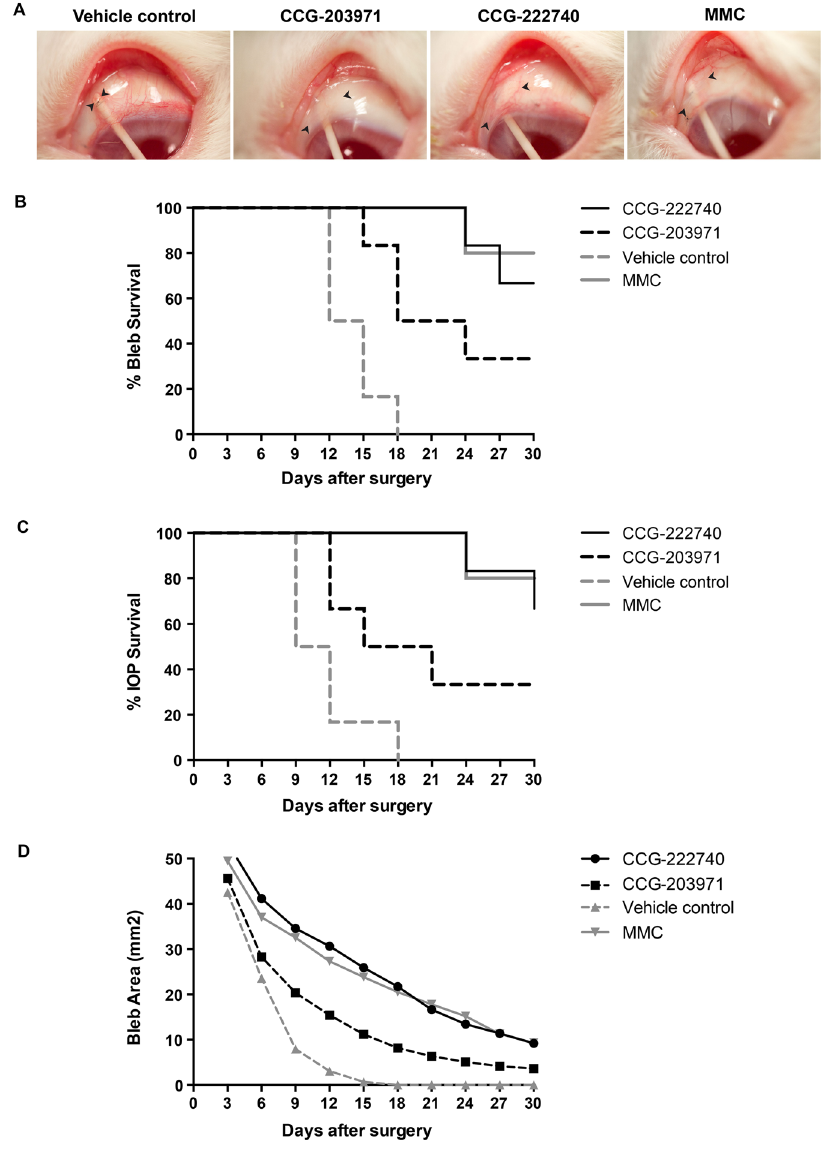
Figure 4. CCG-222740 and CCG-203971 increase the long-term success of surgery in a preclinical model of fibrosis. ( A ) Morphology of blebs after surgery and treatment with CCG-222740, CCG-203071, MMC or vehicle. Arrows indicate bleb edges. ( B ) Kaplan-Meier graph comparing the bleb survival between CCG-222740 [N = 6], CCG-203971 [N = 6], MMC [N = 6], and vehicle control [N = 6]. CCG-222740 and CCG-203971 treatments significantly increased bleb survival by 67% ( P < 0.0005) and 33% ( P < 0.01), respectively, compared to vehicle control. ( C ) Intraocular pressure (IOP) survival, i.e. when the intraocular pressure remains below the baseline IOP measurement. CCG-222740 and CCG-203971 treatments increased IOP survival by 67% ( P < 0.0005) and 33% ( P < 0.05), respectively. ( D ) Comparison of bleb